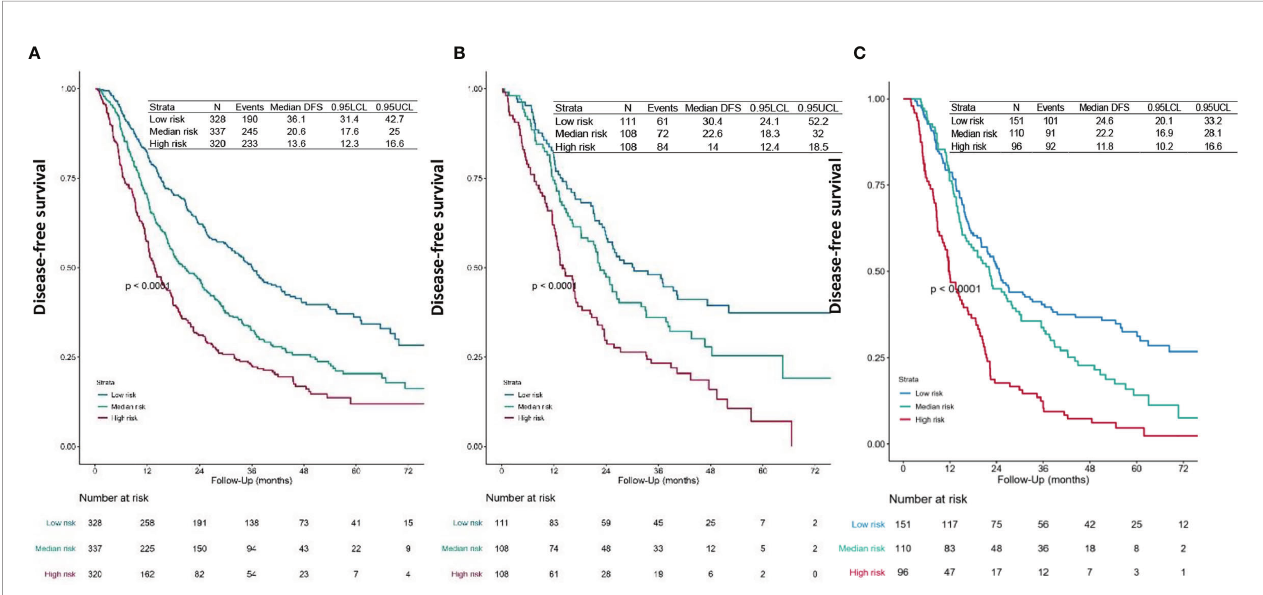
FIGURE 3 | Survival curves. DFS curves for the (A) training set, (B) validation set 1, and (C) validation set 2 of each risk group. The patients-at-risk table is displayed at the bottom of the plots. The risk points for each patient were calculated based on the nomogram ( Figure 1 and Supplementary File 1 ). According to the tertile of the risk points in the training set, all patients were divided into three subgroups, named low-risk group (risk point: 0 – 226), median-risk group (risk point: 226 – 306), and high-risk group (risk point: 306 – 466). DFS, disease-free survival.